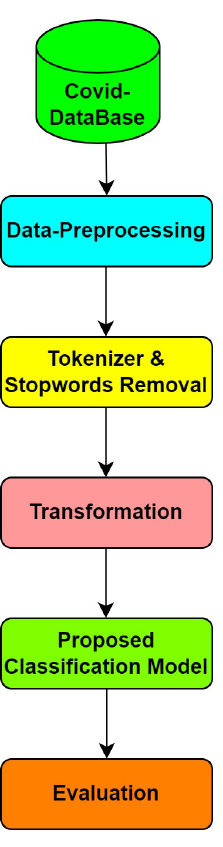
Figure 2. The work flow of the proposed